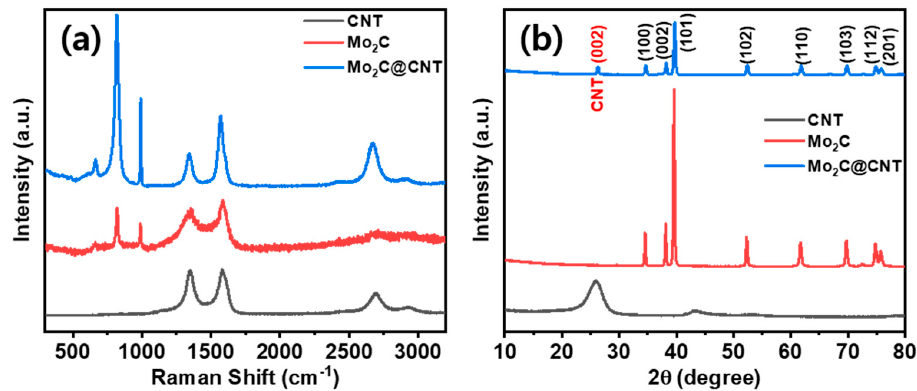
Figure 2. ( a ) XRD using Cu-K α radiation (0.154 nm) and ( b ) Raman scattering using Ar laser source (512 nm) spectra of Mo 2 C, CNTs, and Mo 2 C-CNTs.